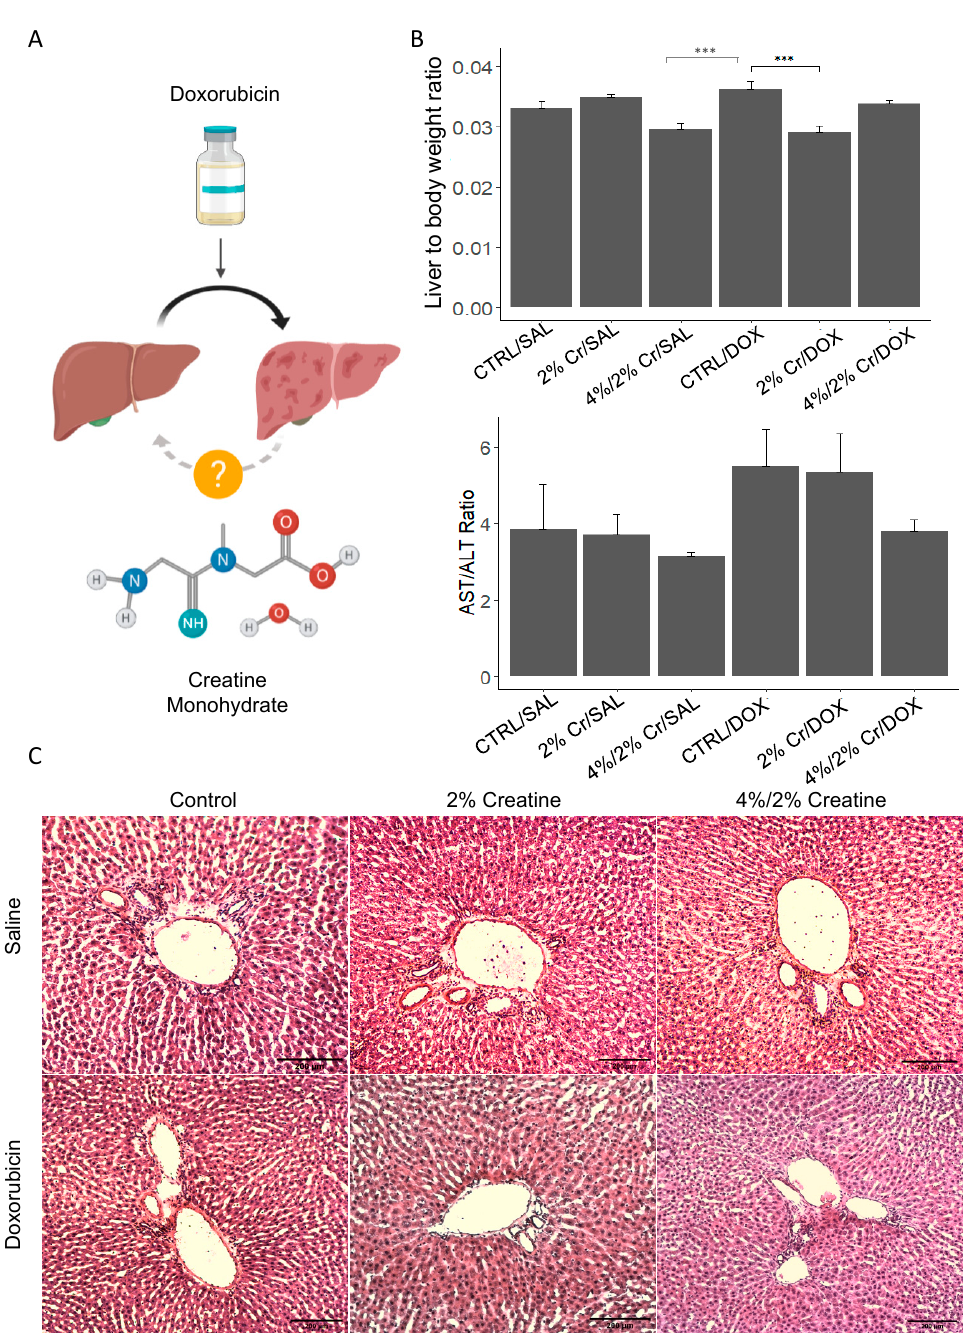
Figure 1. Evaluation of the effect of doxorubicin (DOX) on the overall health of liver and the role of creatine (Cr) in reducing the damage. Schematic illustration describing the hypothesis of the present study ( A ). There was a significant decrease in the liver-to-body weight ratio when 2% Cr/DOX and 4%/2%Cr/SAL were compared toCTRL/DOX (( B ), top row). The AST-to-ALT ratio tended to be elevated in CTRL/DOX and showed a trend toward a reduction in 4%/2% Cr/DOX (( B ), bottom row). Immune cell infiltration was observed in the representative H&E images, but no major change was noted among the groups. Pictures were taken under the magnification of 20 × . ( C ). Data is reported as mean ± SE, *** p <